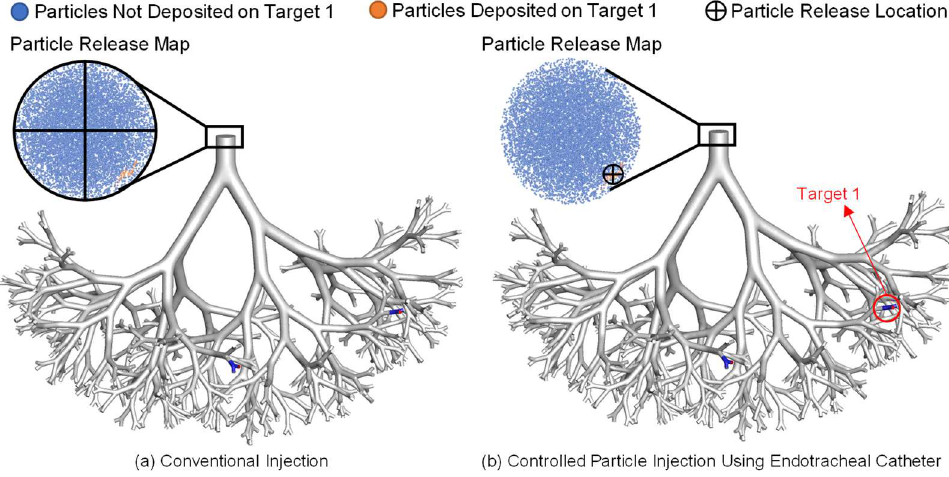
Figure 2. Demonstration of the difference in conventional injection vs. catheter injection (catheter position is determined based on the particle release map generated using conventional injection method): ( a ) Conventional injection, and ( b ) controlled particle injection using endotracheal catheters.